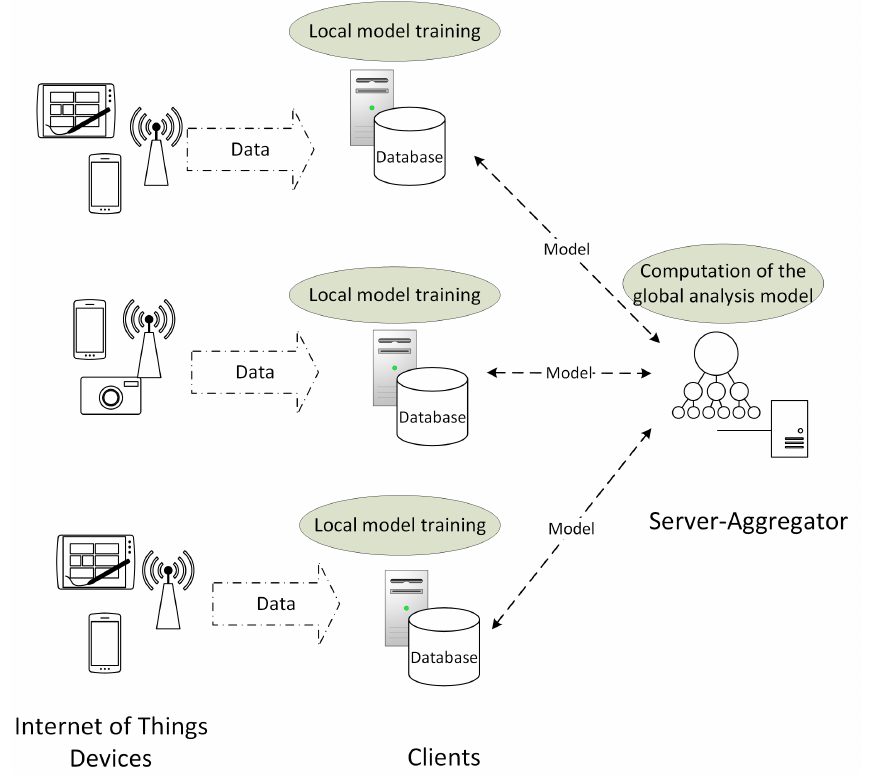
Figure 1. The scheme of federated